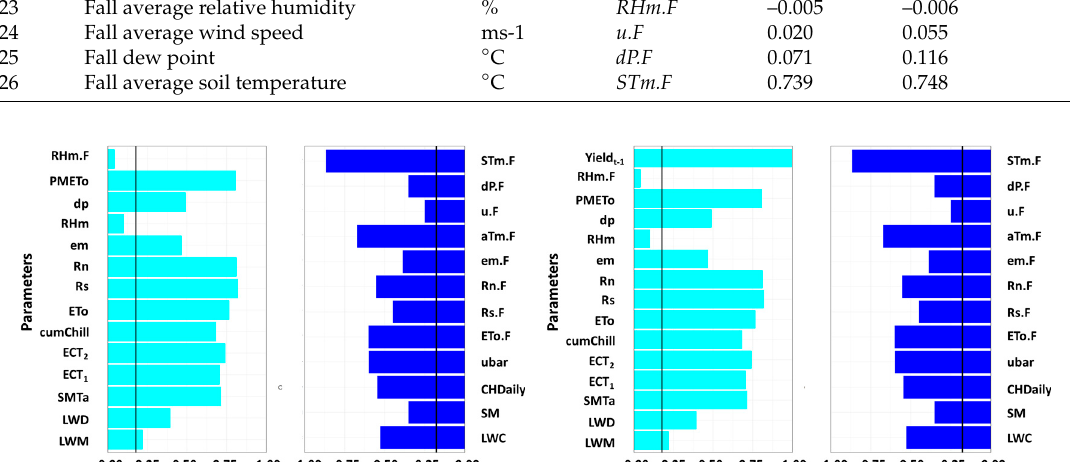
Figure 4. A matrix of correlation among the input parameters as well as the response variable.